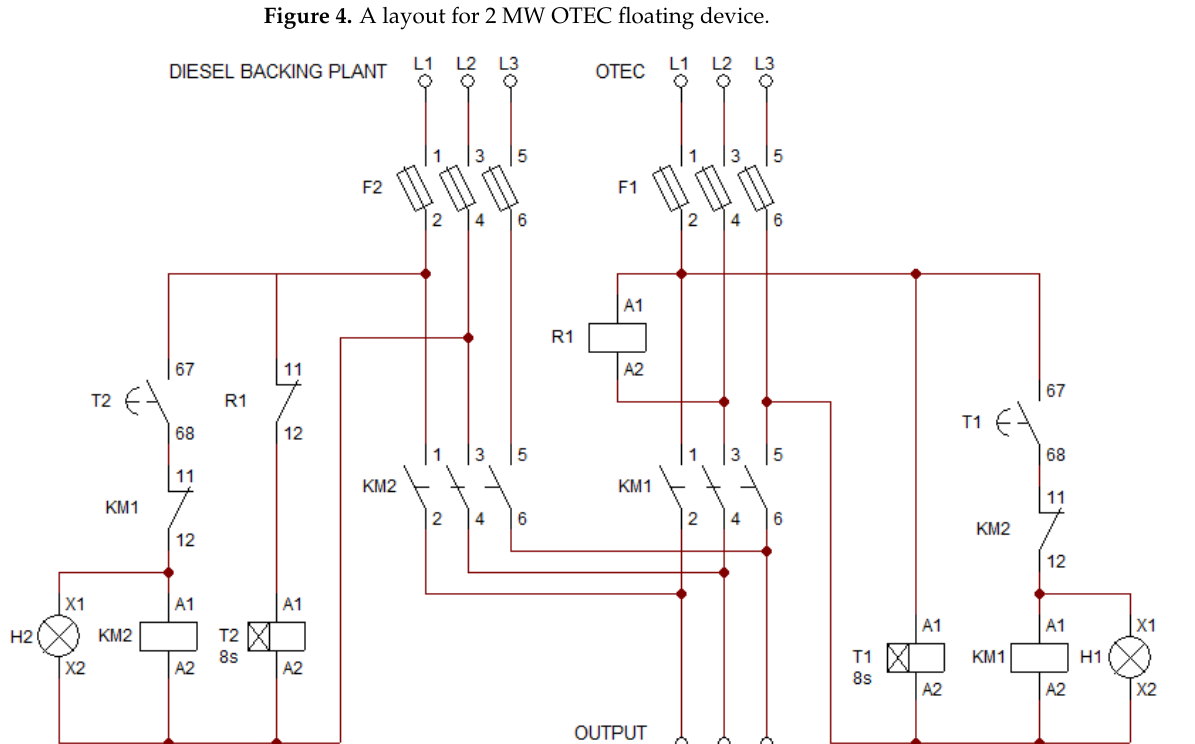
Figure 4. A layout for 2 MW OTEC floating device.